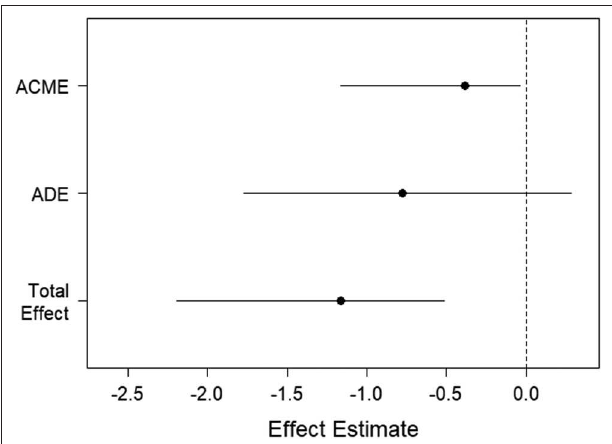
FIGURE 3 | Visual representation of causal mediation of the Rostral anterior cingulate fasciculus gyrus (LRACFG). The Y axis represents the Average causal mediated effect (ACME); the Average direct effect (ADE- residual effect after mediation) of age on experiential emotional intelligence (EXP); and the total effect of the ACME and ADE. The X-axis represents the regression weights (effect estimates).